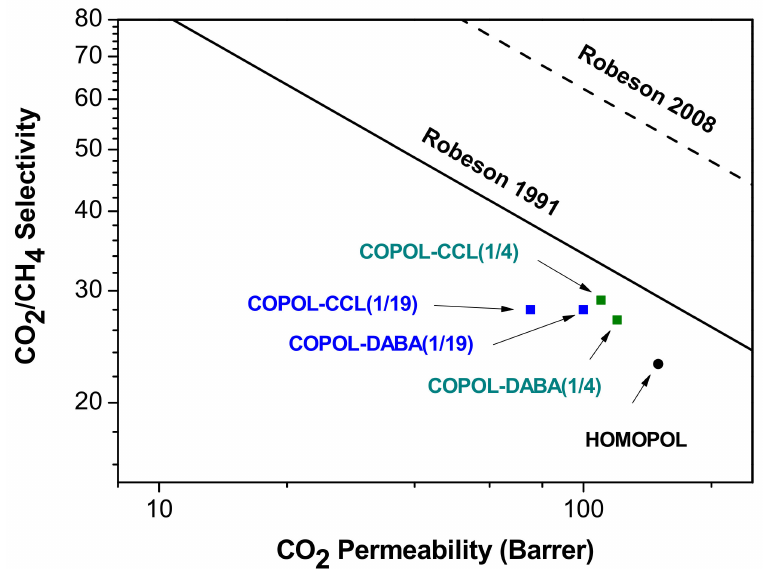
Figure 13. CO 2 /CH 4 selectivity vs. CO 2 permeability